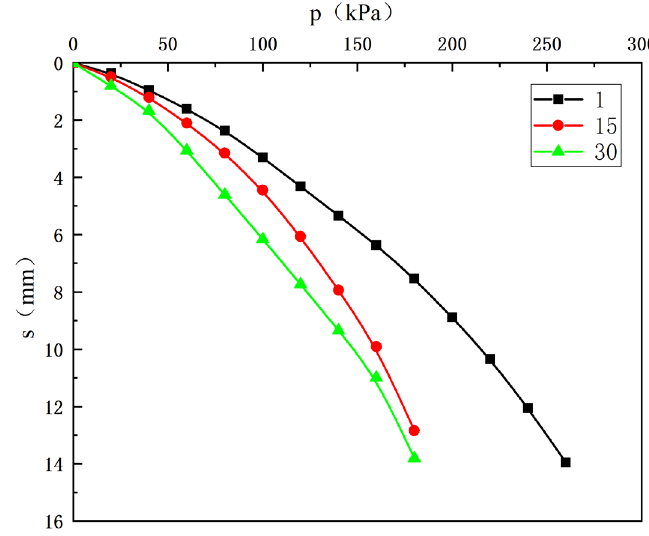
Figure 5. The p–s curves under different cycles.